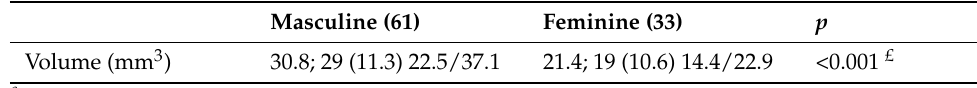
Figure 4. Comparison of the pulp volume values on the teeth on the cleft side and the non-cleft side. Table 3. The medium dental pulp volume value in both